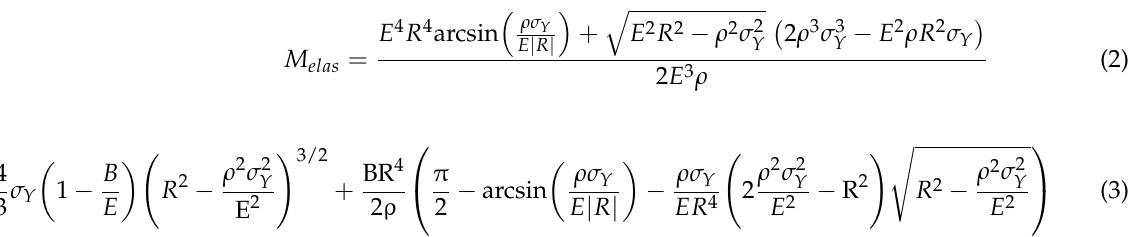
Together, these values for stress are used for the subsequent finite element analy- sis